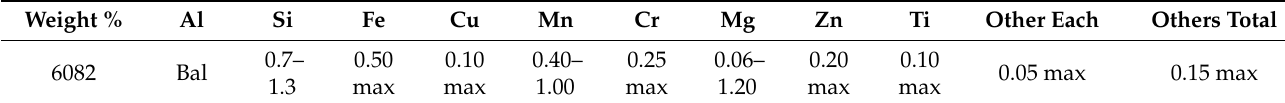
Table 1. Constraints of chemical composition.